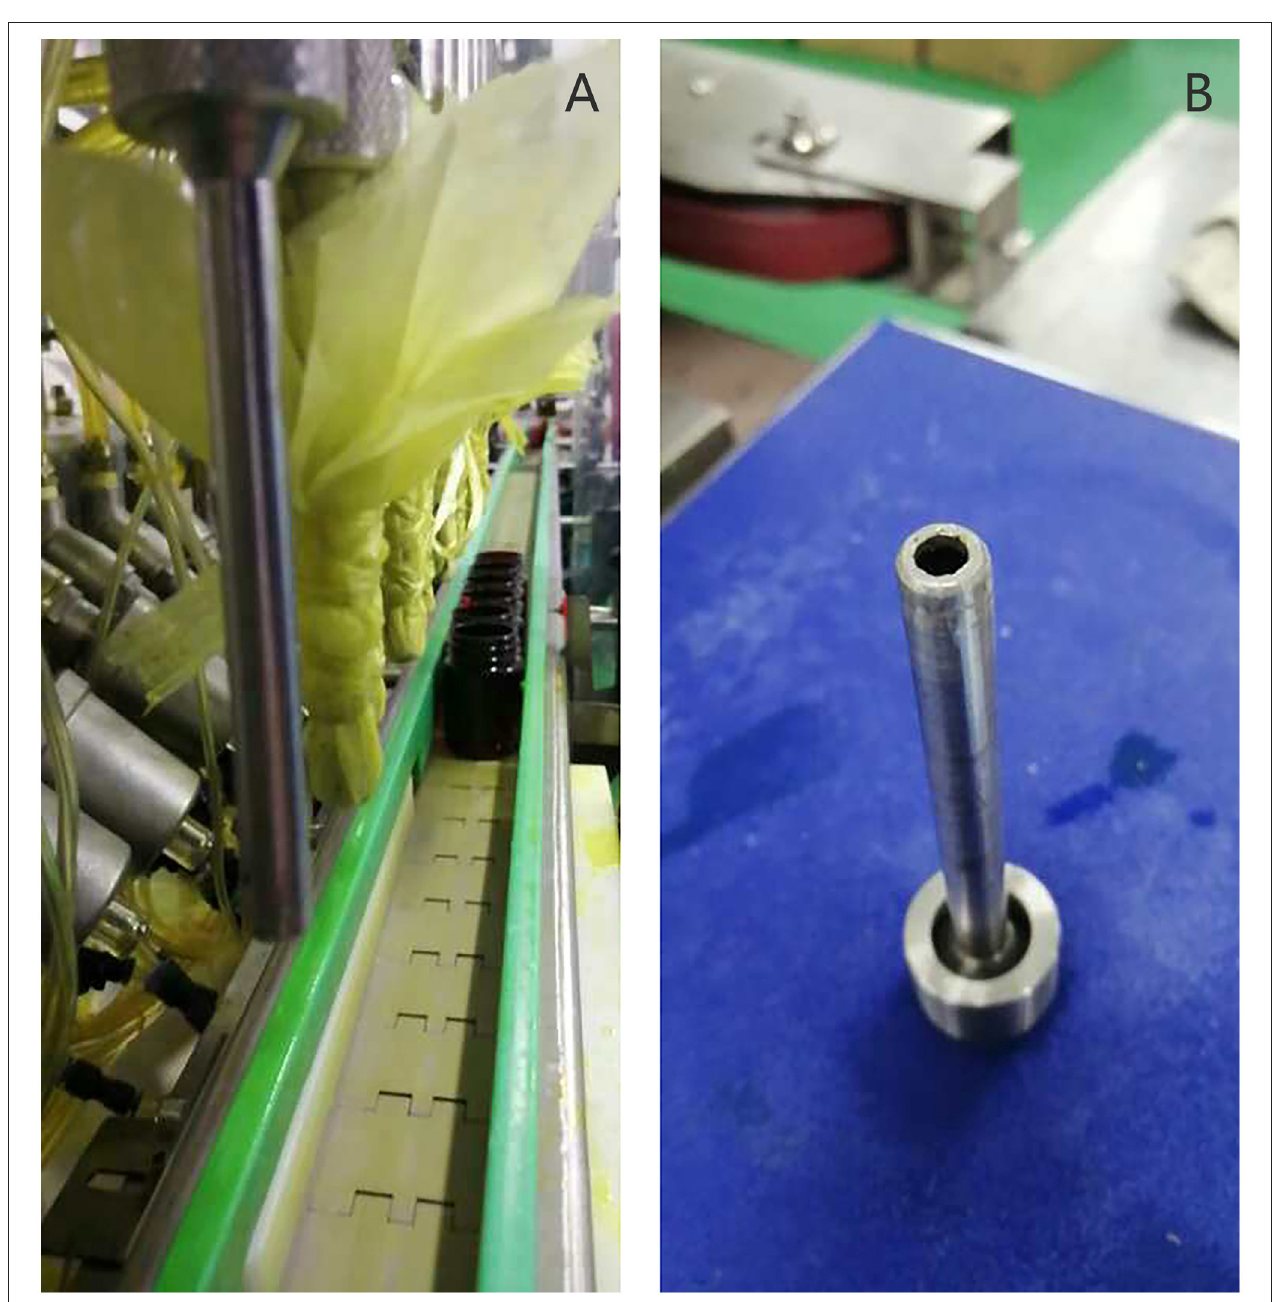
FIGURE 1 | (A) Disinfectant filling line. (B) Filling head with 5.5mm inner